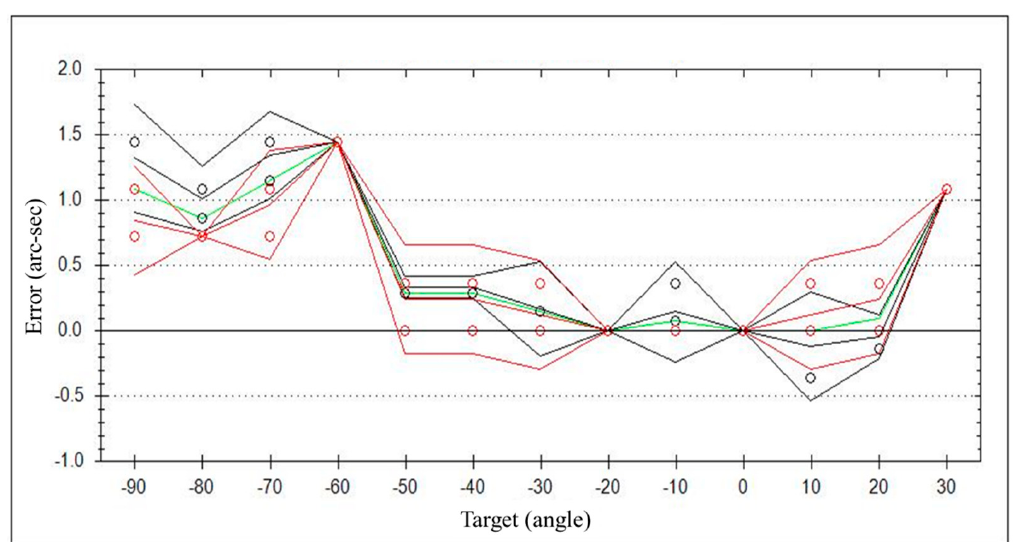
Figure 20. The A-axis before compensation.